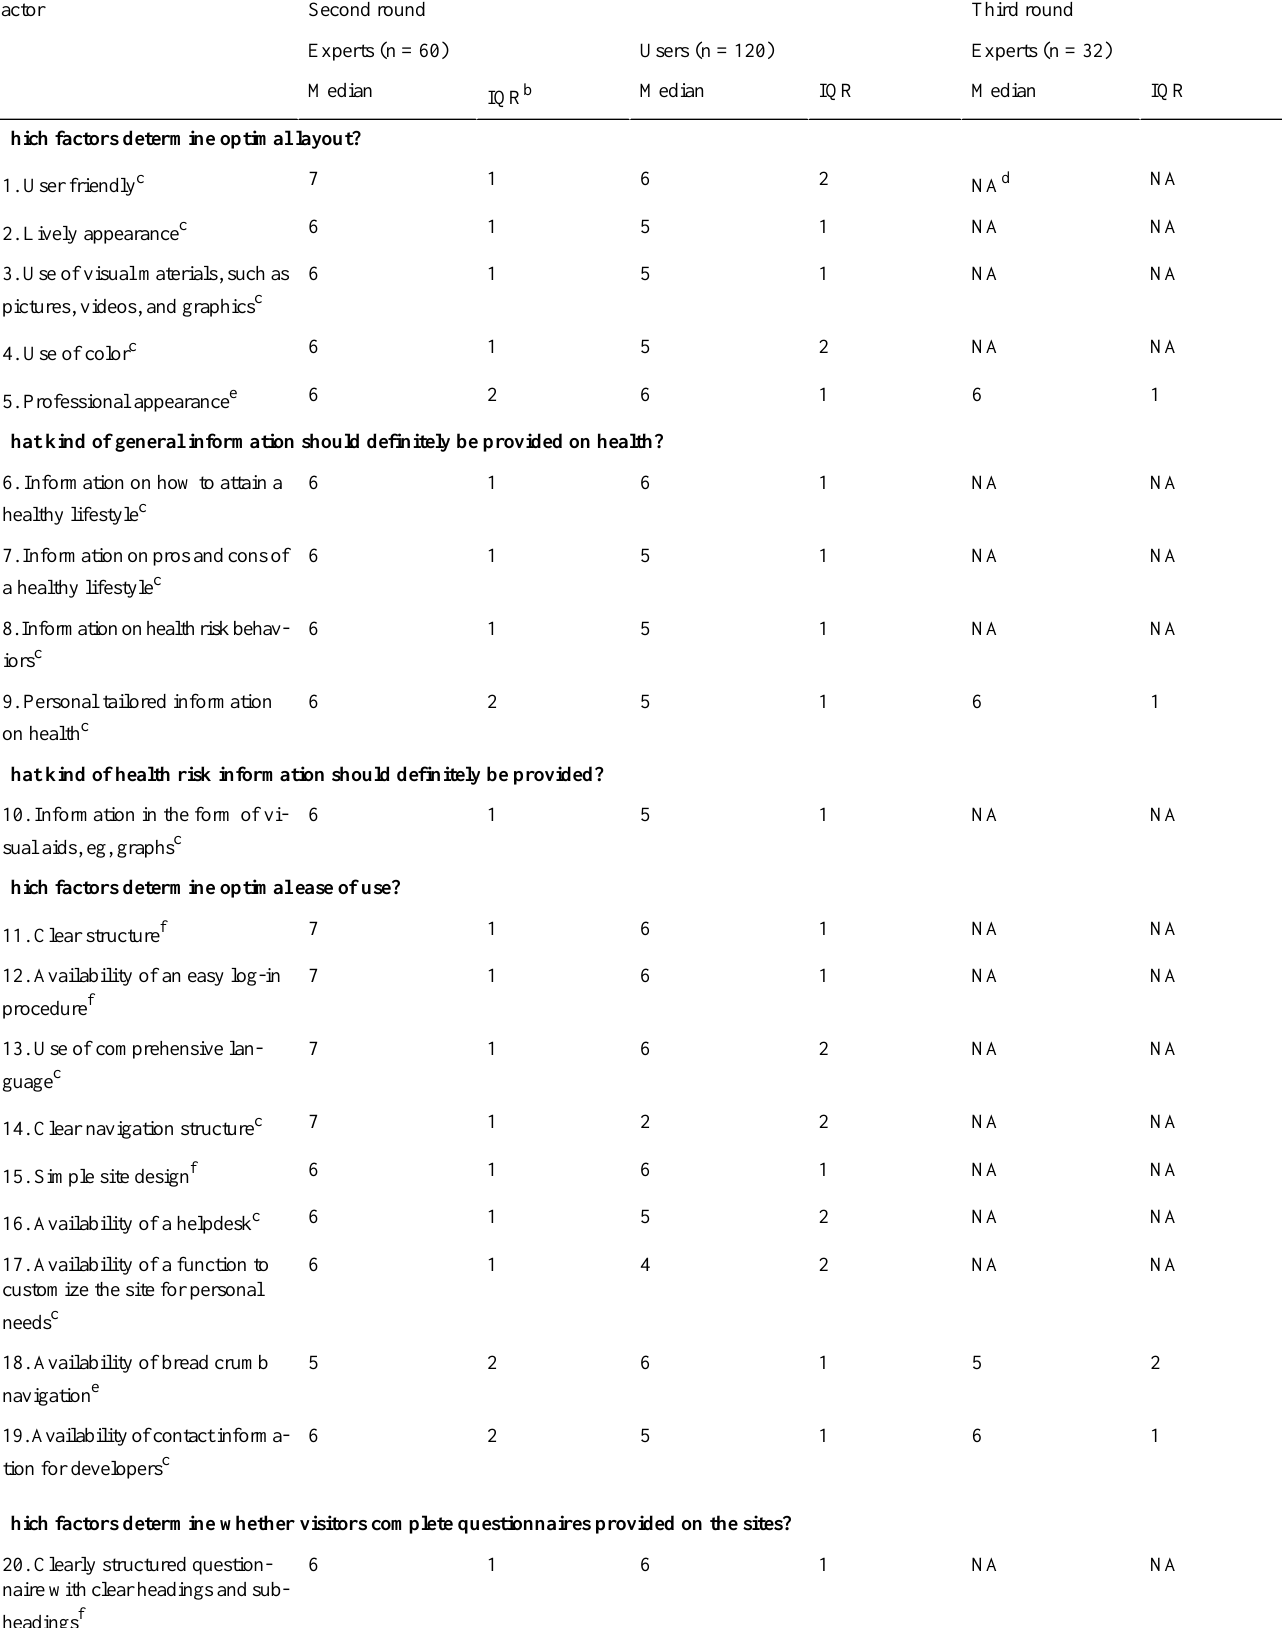
Third roundSecond